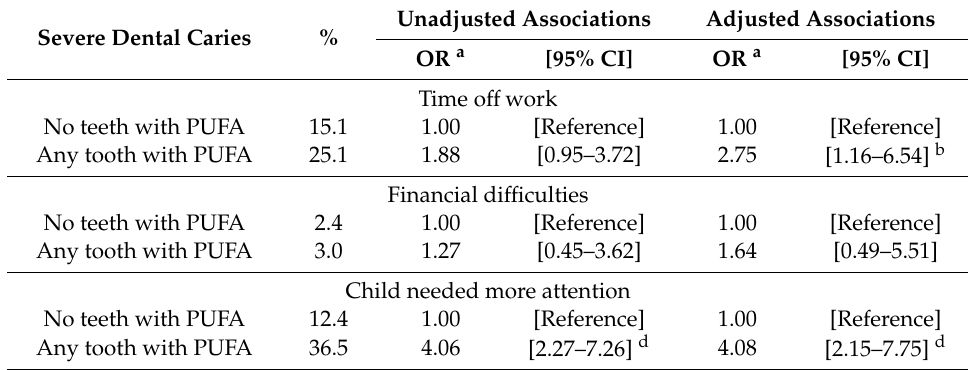
Table 3. Logistic regression models for the association between severe dental caries (any tooth with PUFA) and specific impacts on the parent’s life (n =